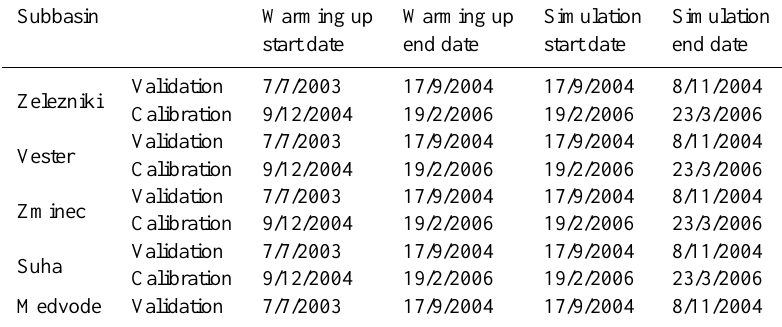
Table 2. Warm up and simulation periods for each subbasin.